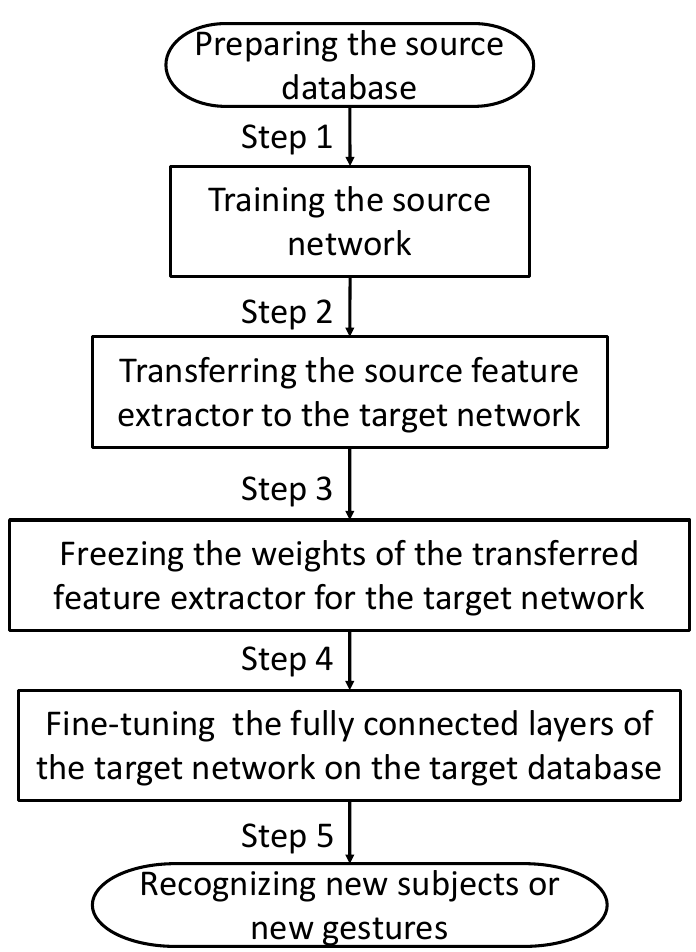
training. In this study, we keep the structure of the target network consistent with the source network. The target network training process is shown in Figure 3.